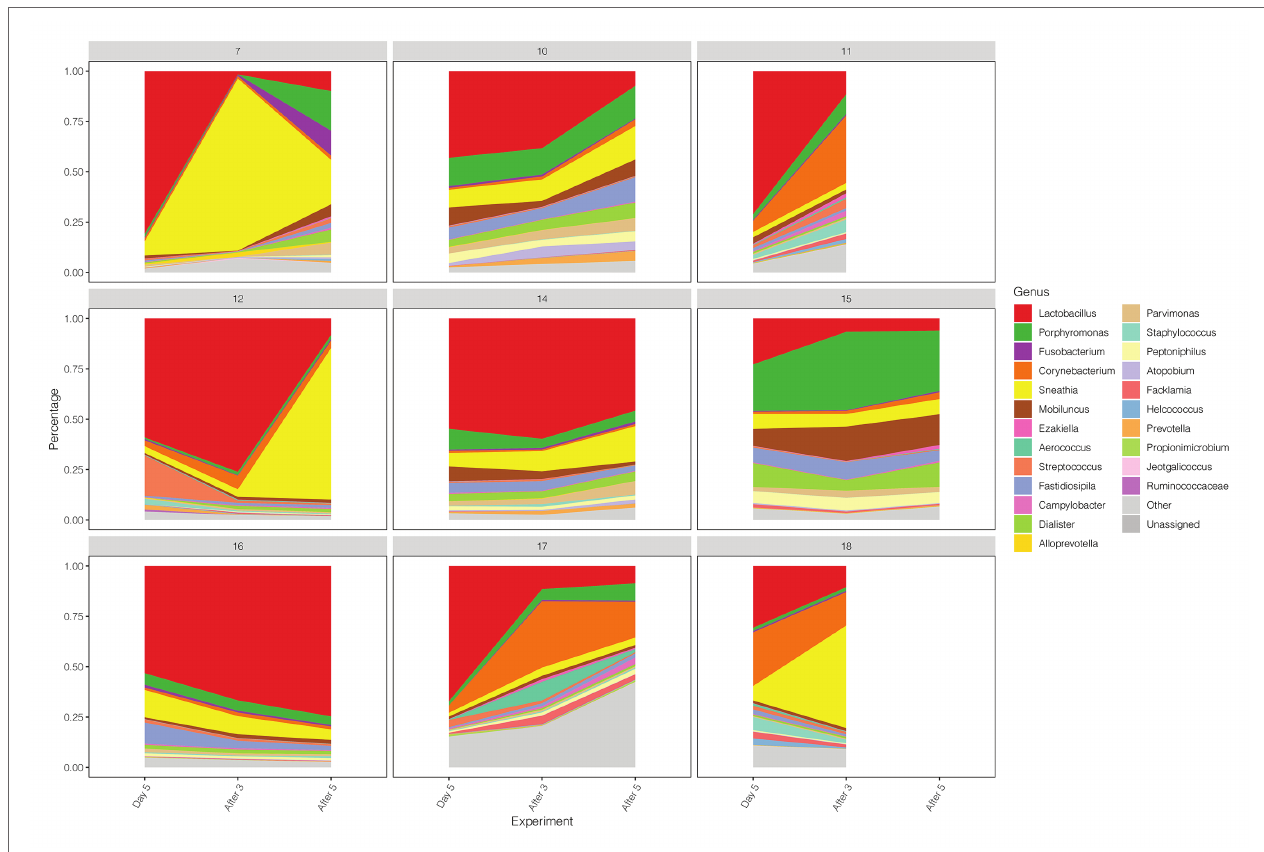
FIGURE 4 | Diversity and abundance of vaginal microbiota between Day 5, After 3, and After 5 in test